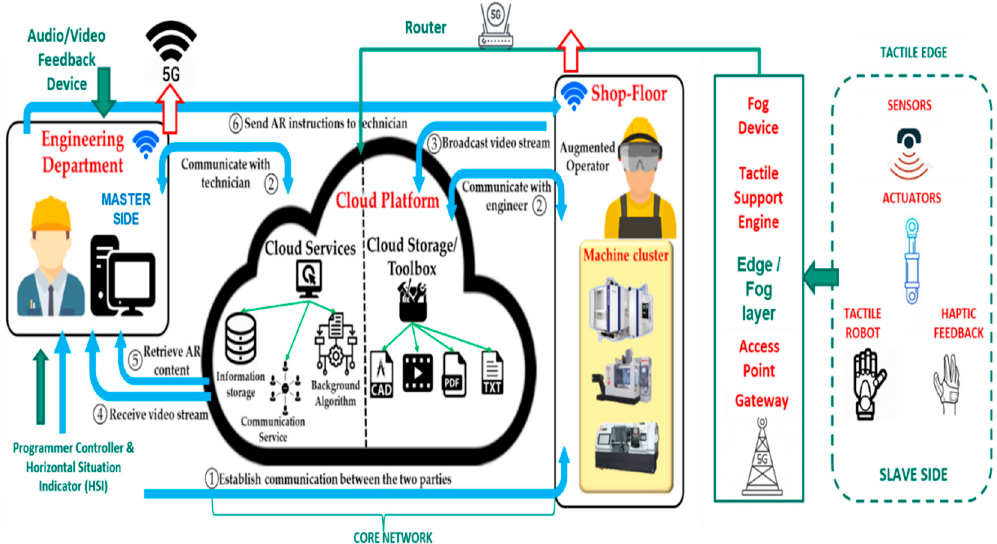
Figure 17. Integrating 5G and TI applications for integrated and adaptive AR maintenance and shop-floor rescheduling (adapted from [59]).